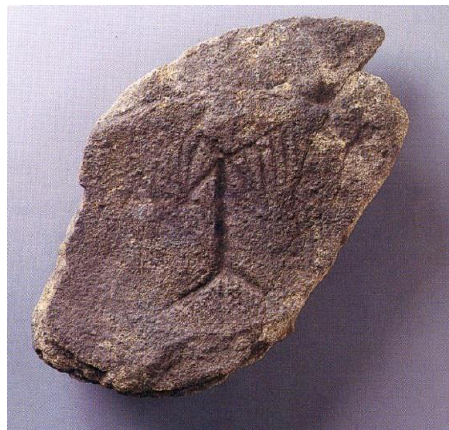
Figure 7. Rock with